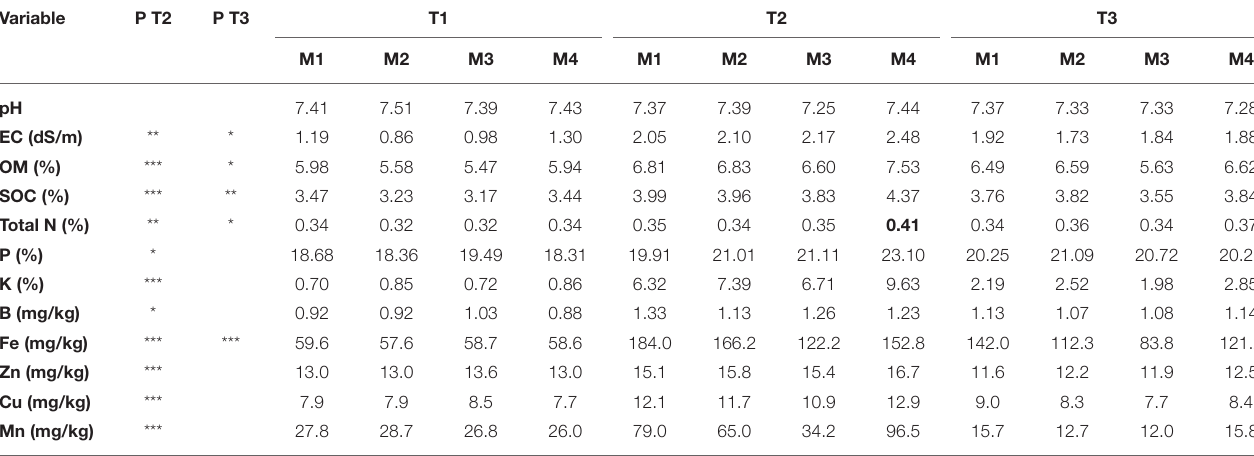
TABLE 3 | Average values and standard errors of soil physicochemical variables (DM, dry matter; OM, organic matter; SOC, soil organic C) in each treatment (M1, M2, M3, M4).